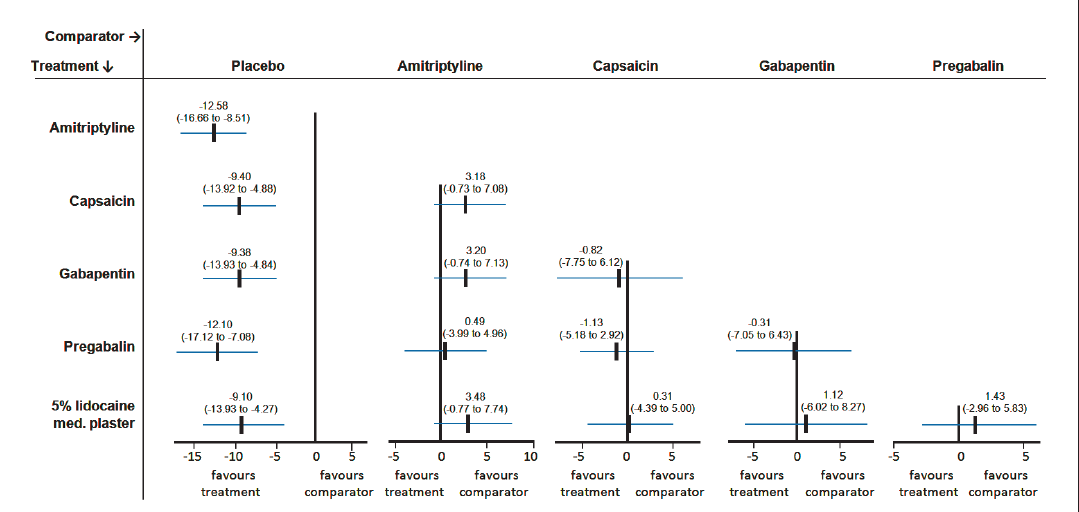
Pain change from